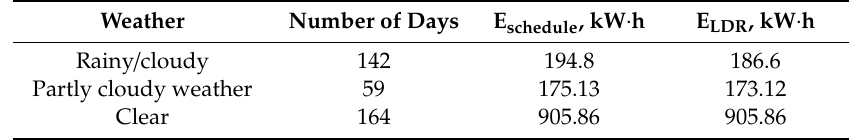
Table 5. Estimated amount of energy generated by solar trackers in various weather conditions.